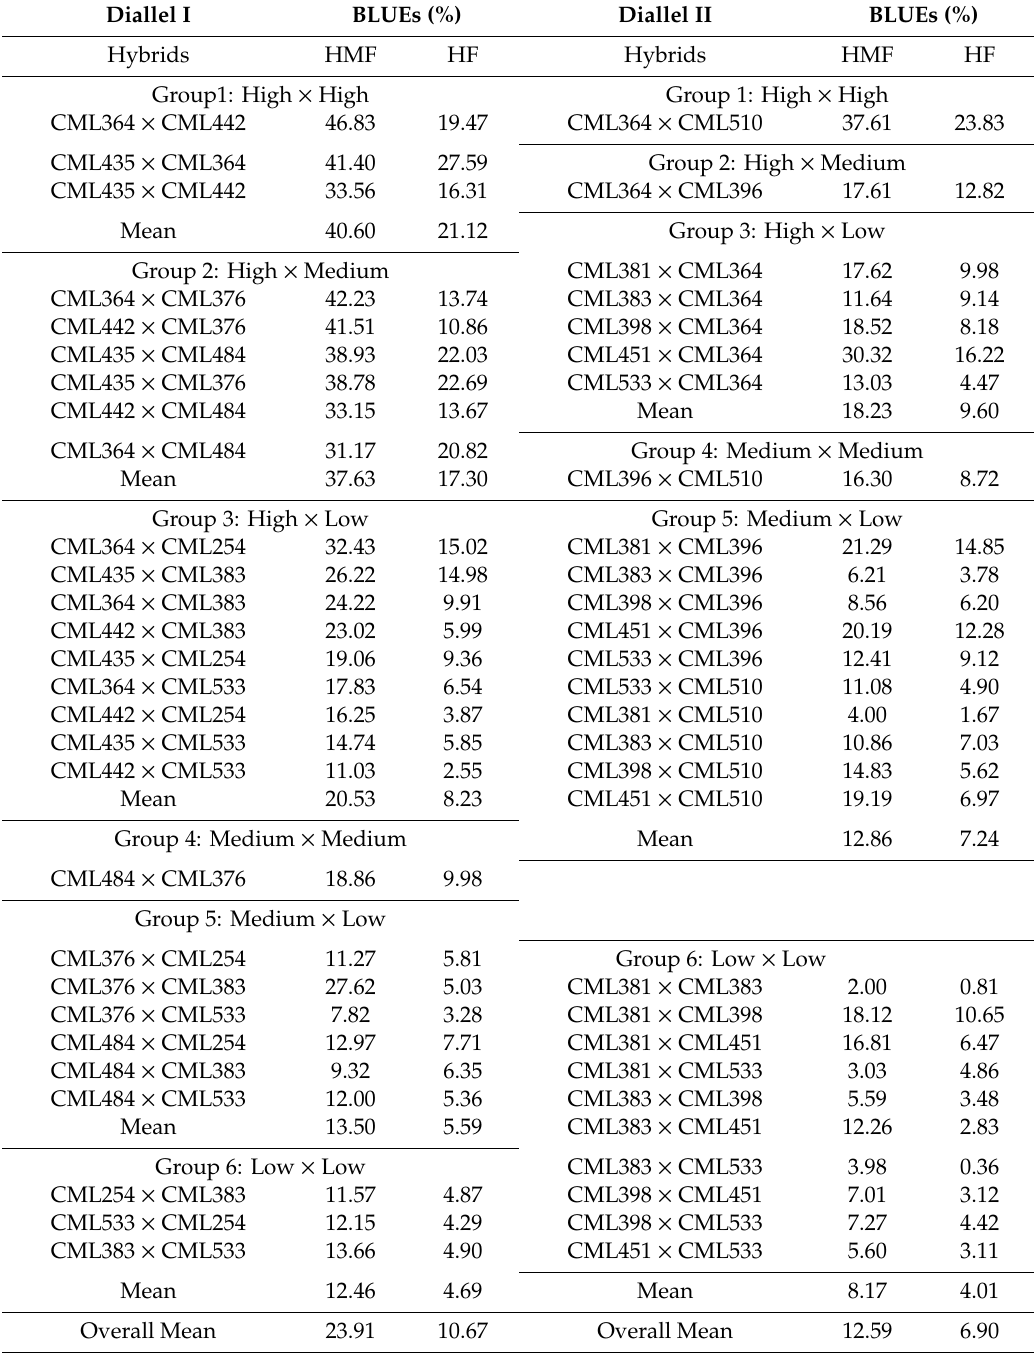
Table 2. Mean performance of hybrids across two environments for HMF and HF in Diallels I and